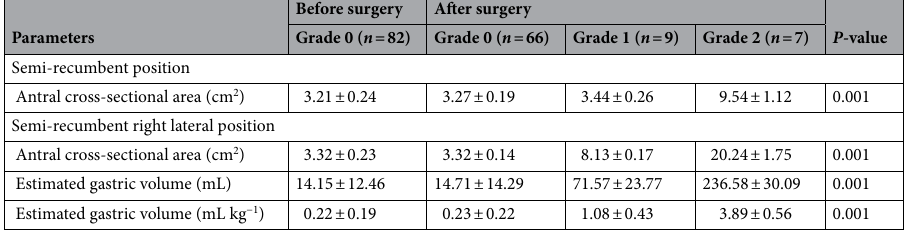
Table 2. Antral cross-sectional areas and estimated gastric volumes between different antrum grades before and after transsphenoidal surgery. Values are presented as mean ± SD.